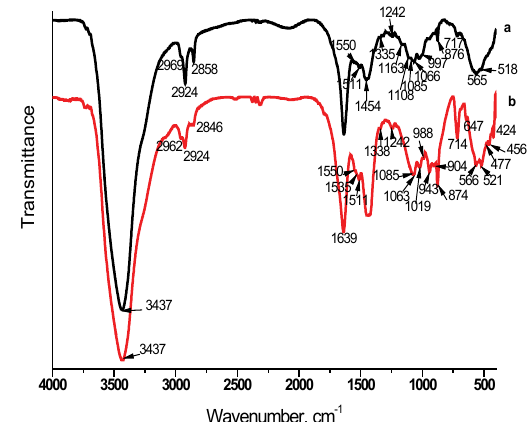
Figure 1. FTIR of pure gelatin (Fluka).